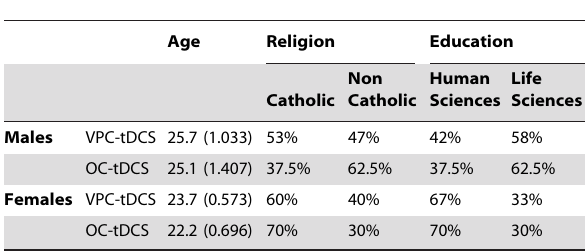
Table 3. Demographic